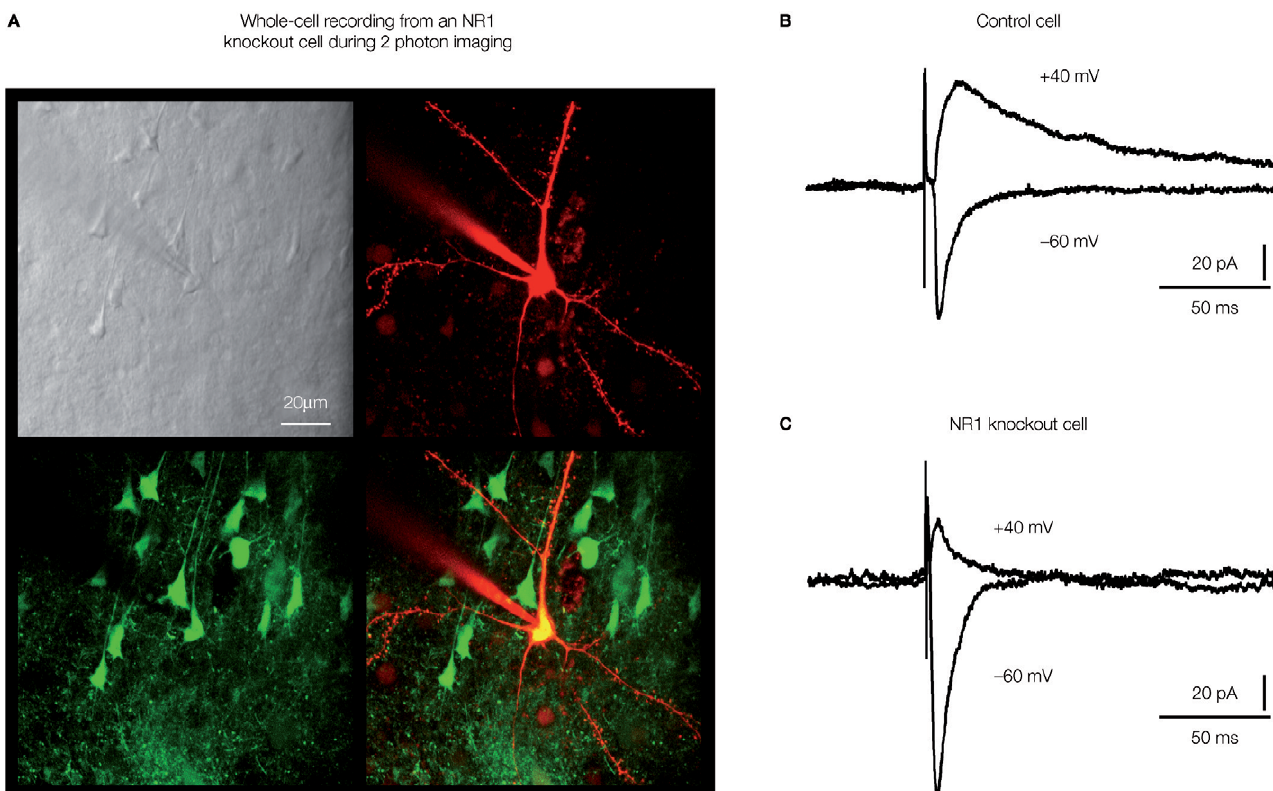
Figure 5 | Highly controlled knockout of NMDA receptors in the barrel cortex. (A) Imaging by two-photon microscopy of lentivector transduced pyramidal neu- rons expressing GFP and Cre recombinase in a fl oxed NR1 mouse. The Dodt contrast image (upper left), shows the whole-cell recording electrode fi lled with Alex 594 (upper right) targeted to a GFP expressing neuron (lower left, overlay lower right). (B) Whole-cell recording of a control layer 2/3 pyramidal neuron near the lentivector injection site. The neuron did not express GFP and had normal NMDA receptor dependent currents evoked by an extracellular stimulus in layer 4 and measured at + 40 mV. (C) Whole-cell recording of a layer 2/3 pyramidal neuron expressing GFP and Cre recombinase in a fl oxed NR1 mouse. Synaptically evoked currents lack the long-lasting NMDA-receptor dependent component at + 40 mV, indicating a functional knockout of NR1. Modifi ed and reproduced with permission from Aronoff and Petersen (2007). Frontiers in Integrative Neuroscience